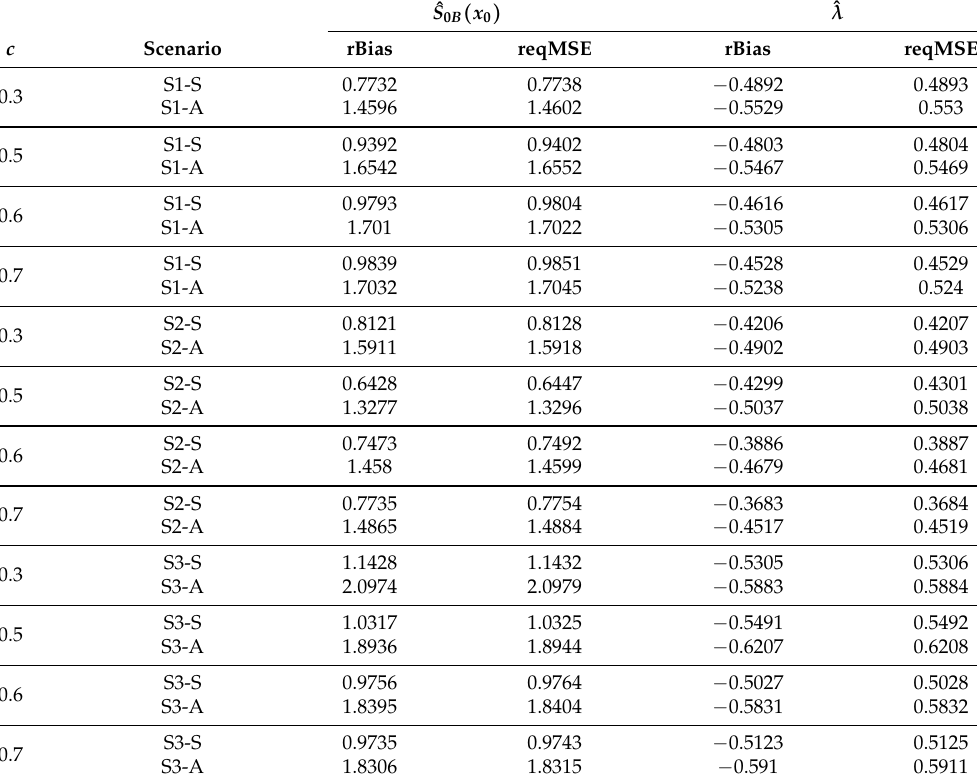
( 0.8 ) and ˆ λ for n = 0